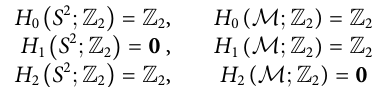
Frontiers in Arti fi cial Intelligence |